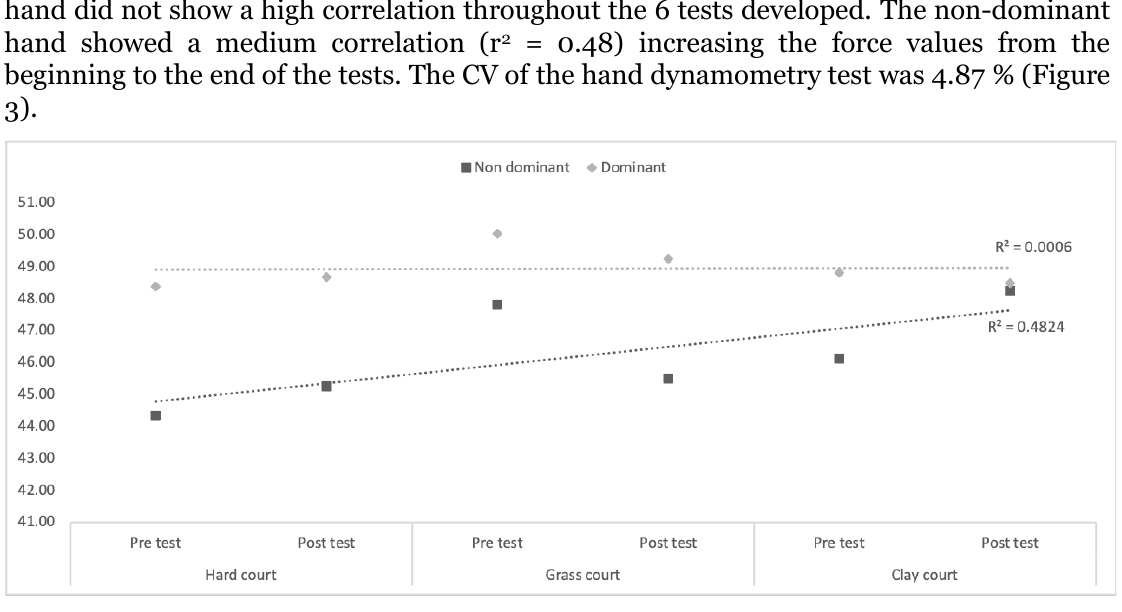
Figure 3. Hand dynamometry results during the wheelchair tennis test